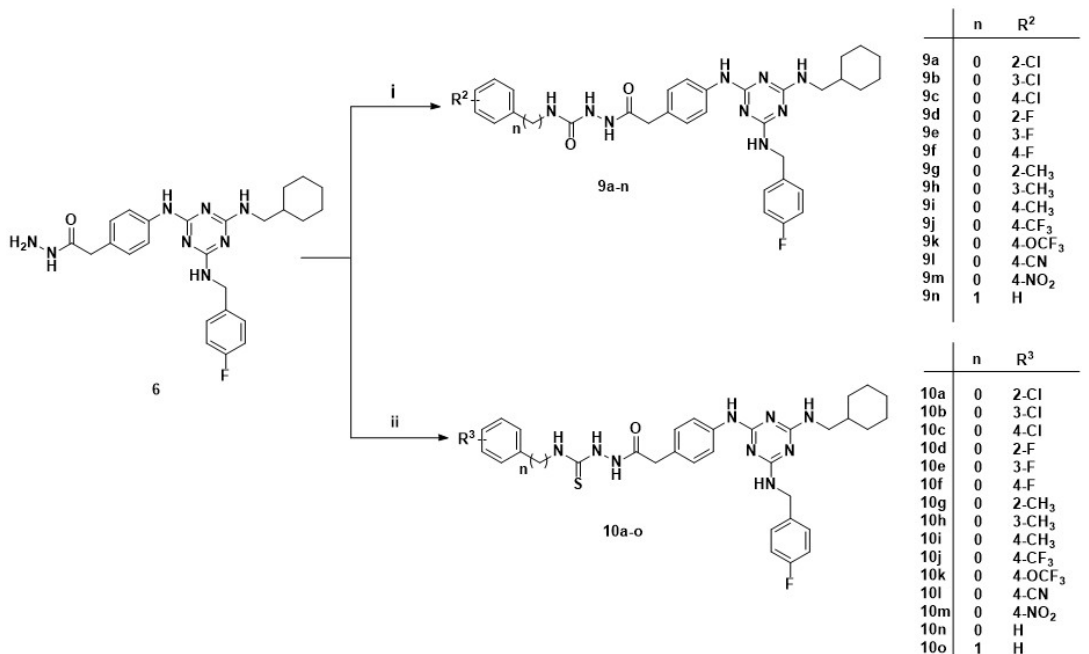
Scheme 3. Synthetic pathway for 1,3,5-triazines derivatives 9a-n and 10a – o . Reagents and condition: (i) various isocyanate, THF, r.t., 2 h; (ii) various isothiocyanate, EtOH, reflux, 2 h.